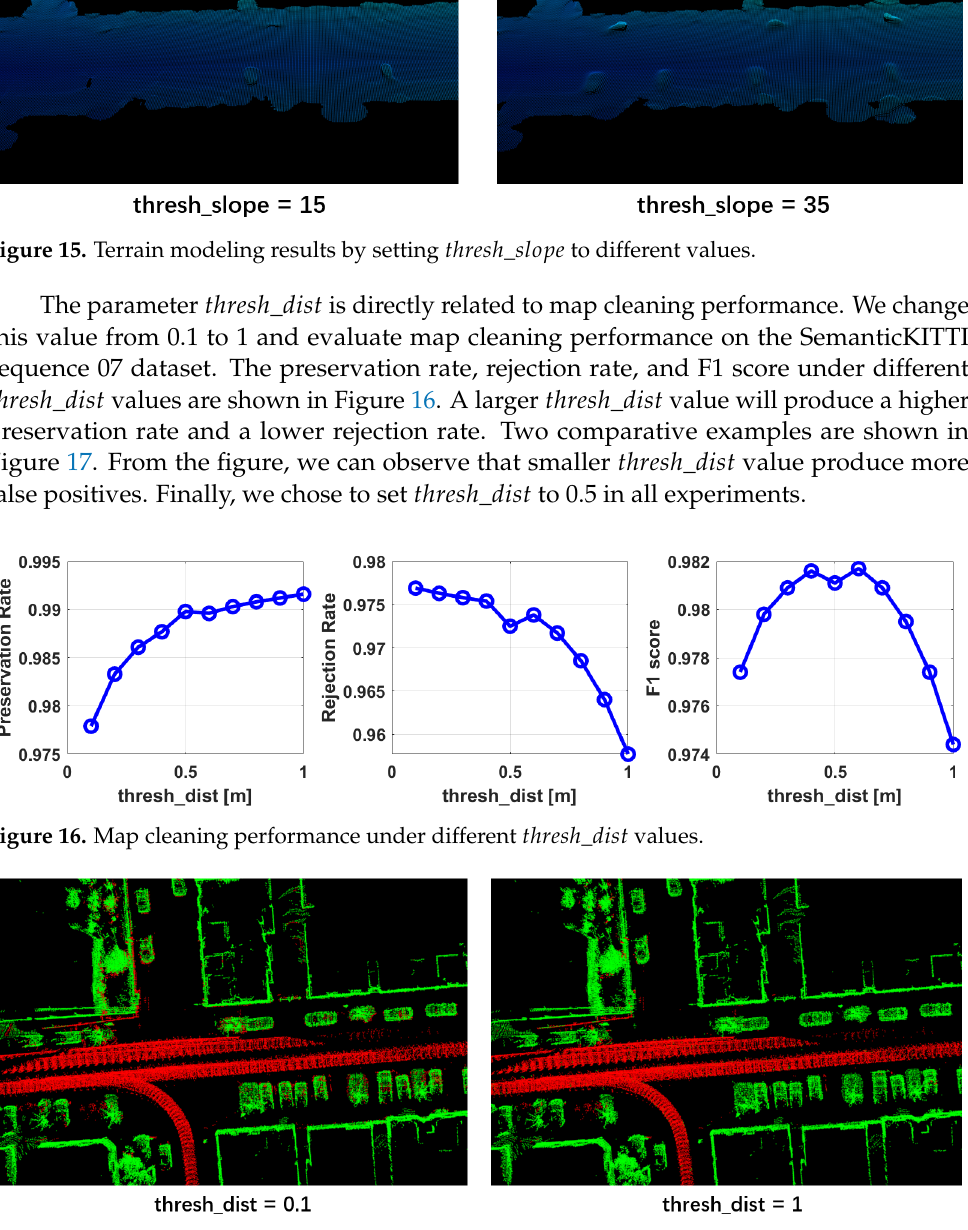
Figure 17. Moving points identification results by setting thresh _ dist to different values. The red points are those identified moving points. The static points are colored in